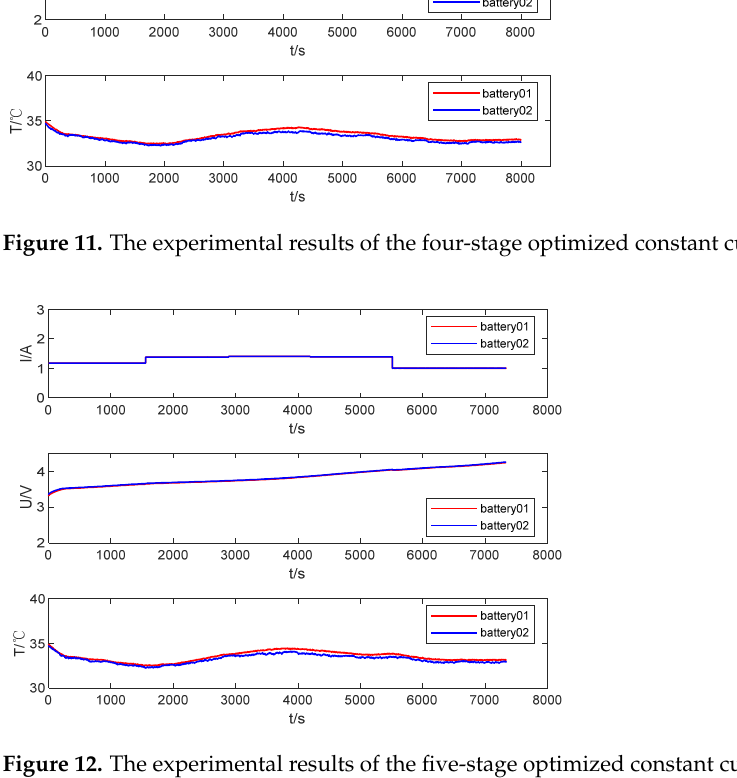
Figure 13. The experimental results of the constant current–constant voltage charging strategy. Through the comparison of the above figure, it can be found that with the increase in charging time, the battery voltage gradually increased to approximately 4.25 V, and the battery temperature first decreased and then increased from 35 °C. The reason the temperature decreased during the initial stage of charging was that the time was not long enough to ensure that the internal chemical reaction of the battery had reached a relatively stable state. The voltage and temperature curves of the three optimized charging methods proposed are generally consistent. The three-stage constant current charging took the shortest time, and the actual battery capacity was reached after 6870 s. The four-stage constant current charging took the longest, and it took a total of 7998 s to fully charge. Additionally, the five-stage constant current charging took a total of 7339 s. However, correspondingly, the temperature rise of the three-stage constant current